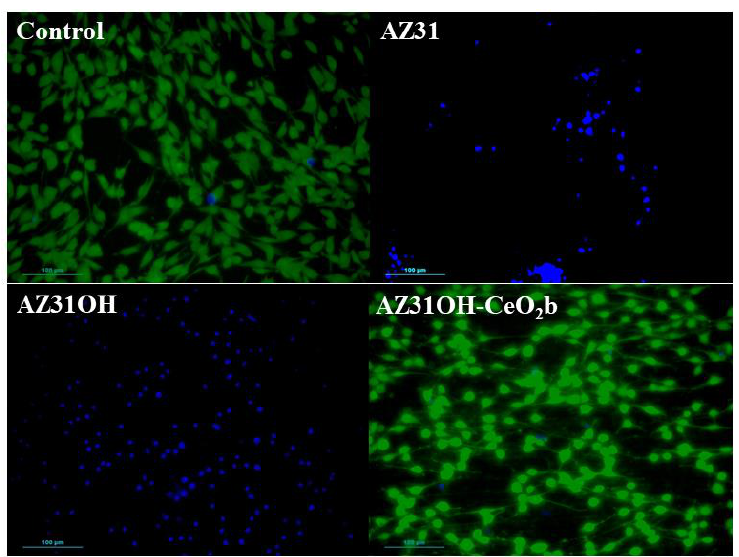
Figure 8. Fluorescence microscopy of MC3T3-E1 cell viability determined by calcein–AM/Hoechst staining after 24 h on AZ31, AZ31OH, and AZ31OHCeO 2 b discs.